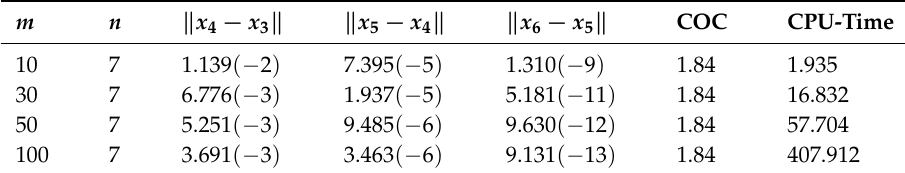
Table 6. Performance of new method (NM) for Example 6.